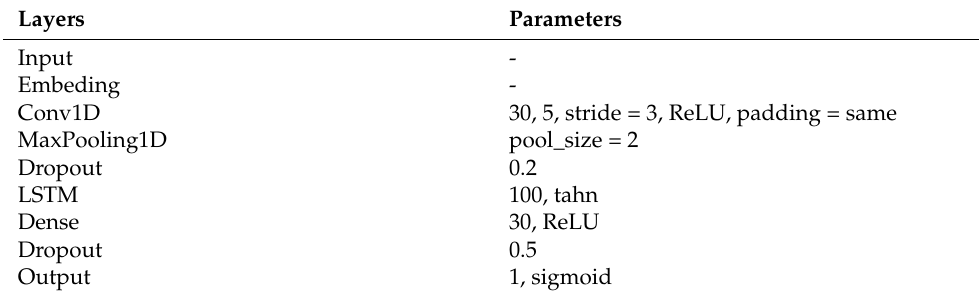
Table 5. Topology of the CNN+LSTM model.